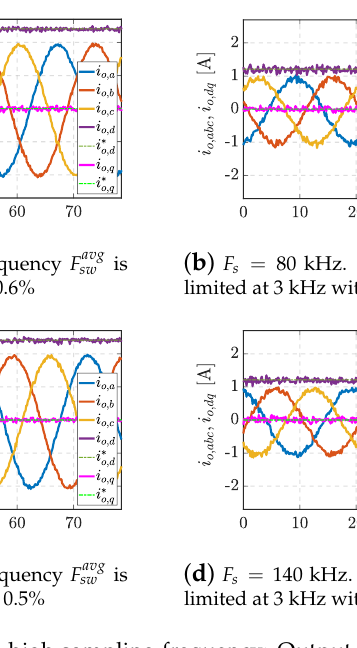
Figure 10. Experimental results at high sampling frequency: Output currents in abc and dq-frame. At t = 40 ms, the reference amplitude for the abc-frame current changes from 1 A to 2